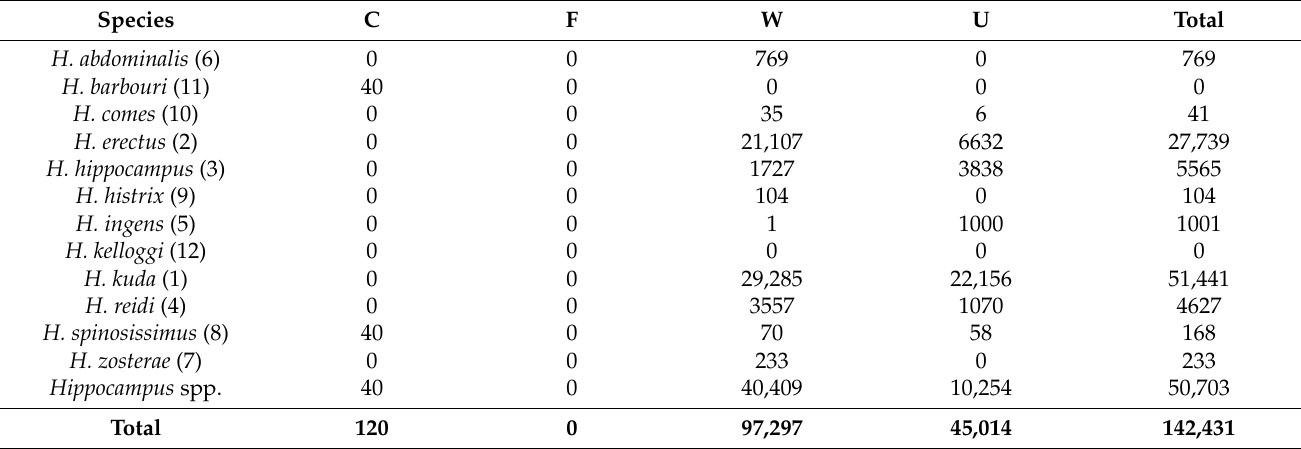
Table 2. Import numbers (individuals) of live-traded Hippocampus species in the EU over 1997–2003 [69] (ranking 1 to 12). Hippocampus spp. = other species and unidentified. Source: C = captive-bred, F = born in captivity, W = wild-caught, U = unknown and unmentioned. Re-exports are